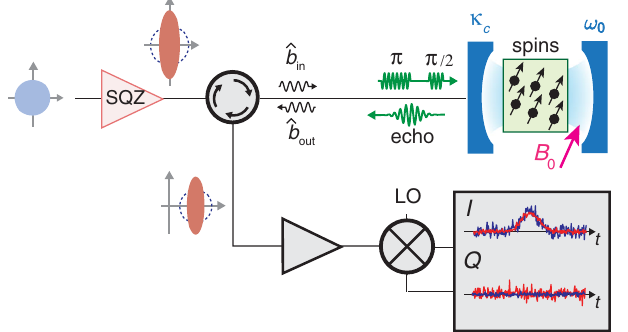
FIG. 1. Principle of squeezing-enhanced pulsed magnetic reso- nance. A squeezed vacuum state is incident on an ESR cavity of frequency ω 0 . The cavity contains the spins to be detected, which are tuned into resonance at ω 0 by a dc magnetic field B 0 . A Hahn echo microwave pulse sequence ( π = 2 − τ − π − τ ) is applied to the spins, leading to the emission of an echo in the detection wave- guide on the X quadrature. This echo is noiselessly amplified along X before its homodyne demodulation with a local oscillator (LO) phase such that I ð t Þ is proportional to X ð t Þ . The traces in the bottom right-hand gray box, which are not real data, depict schematically the expected difference between SQZ off (blue) and SQZ on (red) output quadrature signals when the squeezed quadrature is aligned along the echo emission quadrature X ; the signal-to-noise ratio is improved on the I quadrature, which contains the entire echo